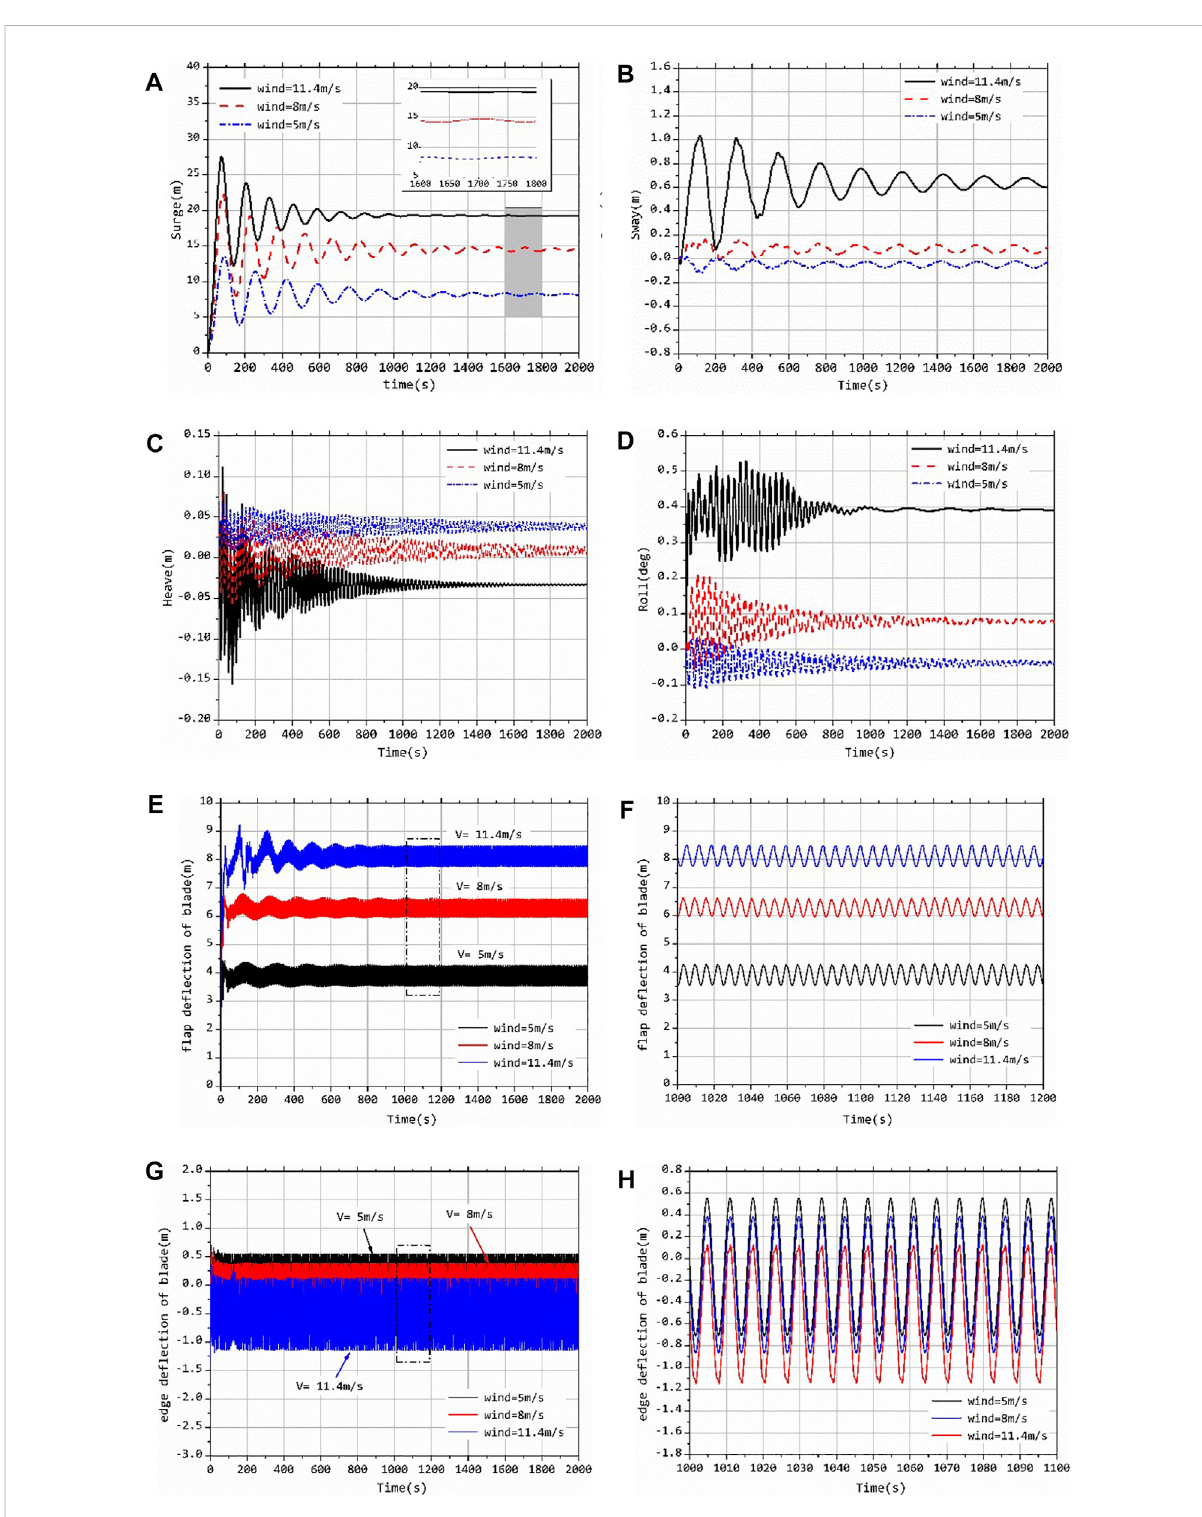
FIGURE 5 Motions of fl oating platform and de fl ection under different wind speeds: (A) Surge; (B) Sway; (C) Heave; (D) Roll; (E) pitch; (F) Yaw; (G) fl ap de fl ection; (H) partial enlargement in fl ap de fl